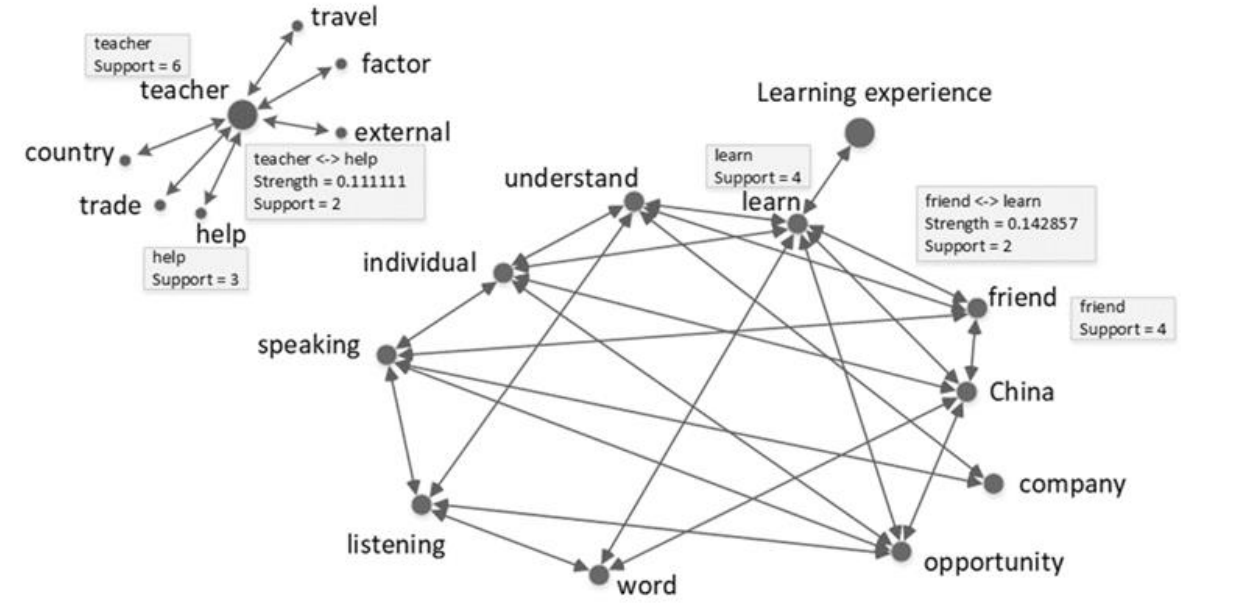
Figure 2. English majors’ social network analysis.